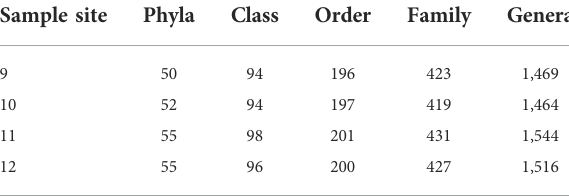
TABLE 2 Taxonomic rank diversity of the metagenomic analysis at each sample